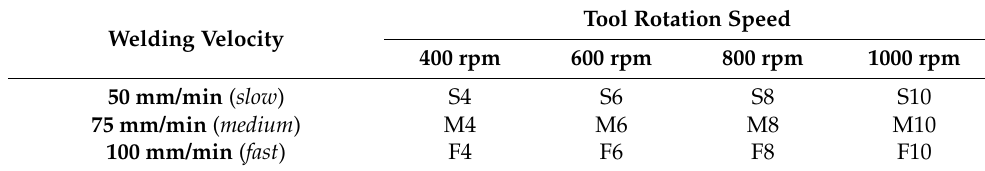
Table 3. Welding parameters and sample designations.